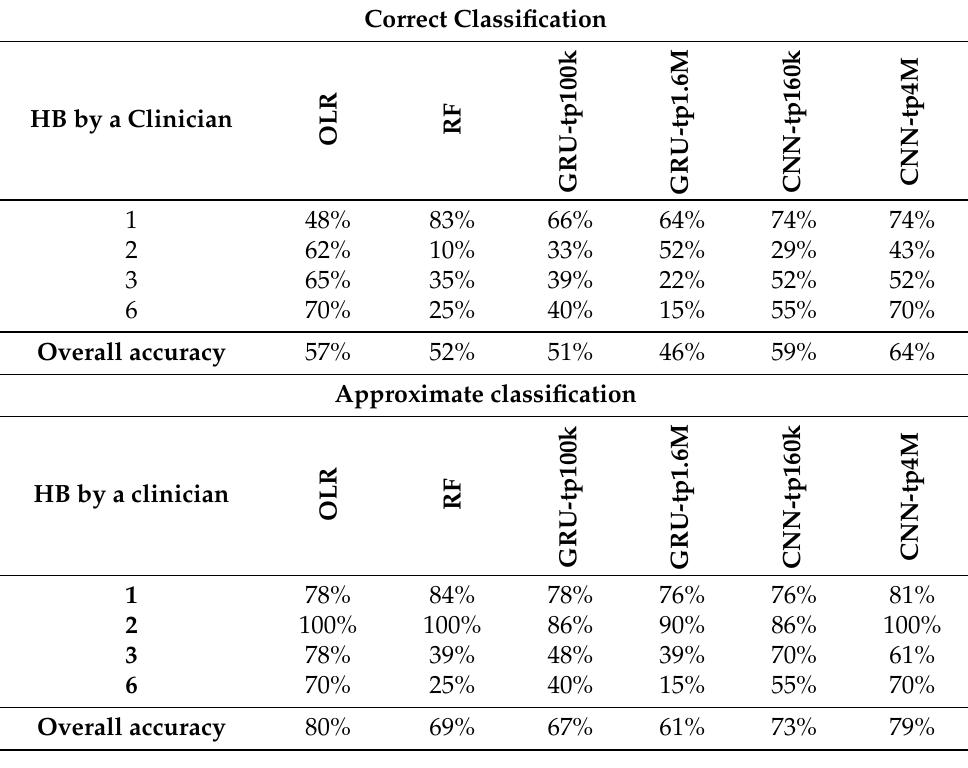
Table 5. Comparison of classification of all models. Both the correct and approximate classifications are considered.